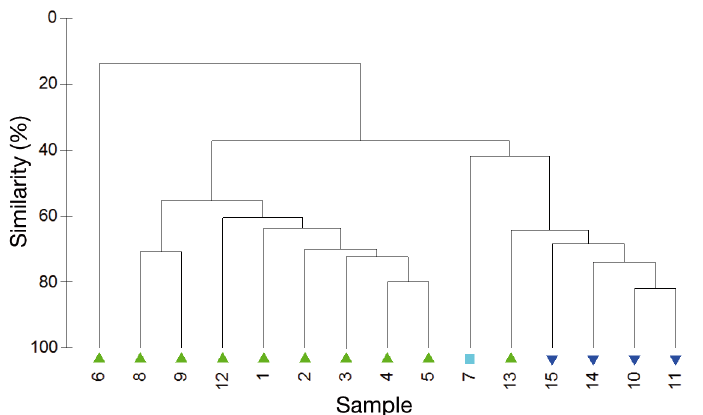
Fig. 3. Cluster analysis of flocculent matter samples. Dendrogram shows the mat-specific and bulk flocculent matter samples as sepa- rate clusters. Dendrogram is constructed using hierarchical cluster- ing (using group-average linking) based on Bray-Curtis dissimilarity measurements. Symbols indicate sample type; green triangles: bulk flocculent matter, blue triangles: bacterial mat samples, square: gaseous